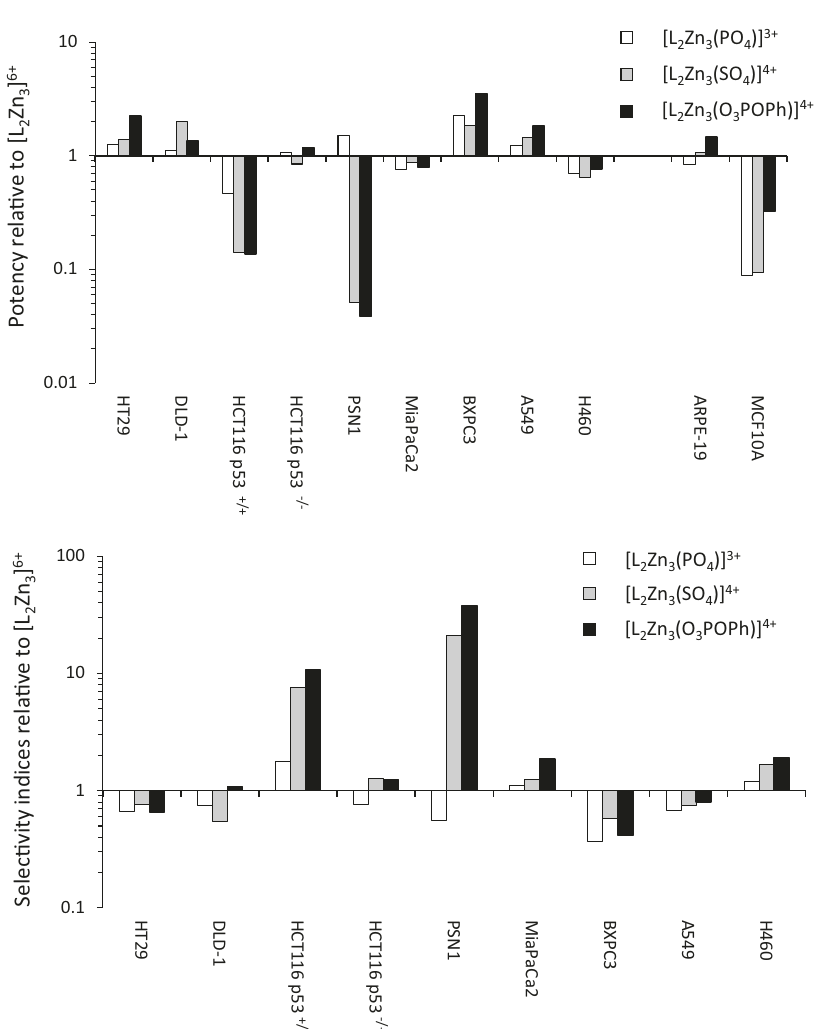
Fig. 6 Effect of the complex anion on potency and selectivity. a The effect of various anions on the potency of the Zn 2 + complex; this is expressed as relative potency which is de fi ned as the IC 50 of [ L 2 Zn 3 (PO 4 )] 3 + , [ L 2 Zn 3 (SO 4 )] 4 + or [ L 2 Zn 3 (O 3 POPh)] 4 + divided by the IC 50 of [ L 2 Zn 3 ] 6 + (values <1 and >1 indicate increased and decreased potency respectively). b Effects of the anion on selectivity; these results are expressed as relative SI de fi ned as the SI of [ L 2 Zn 3 (PO 4 )] 3 + , [ L 2 Zn 3 (SO 4 )] 4 + or [ L 2 Zn 3 (O 3 POPh)] 4 + divided by the SI of [ L 2 Zn 3 ] 6 + (values >1 and <1 indicate increased and decreased selectivity